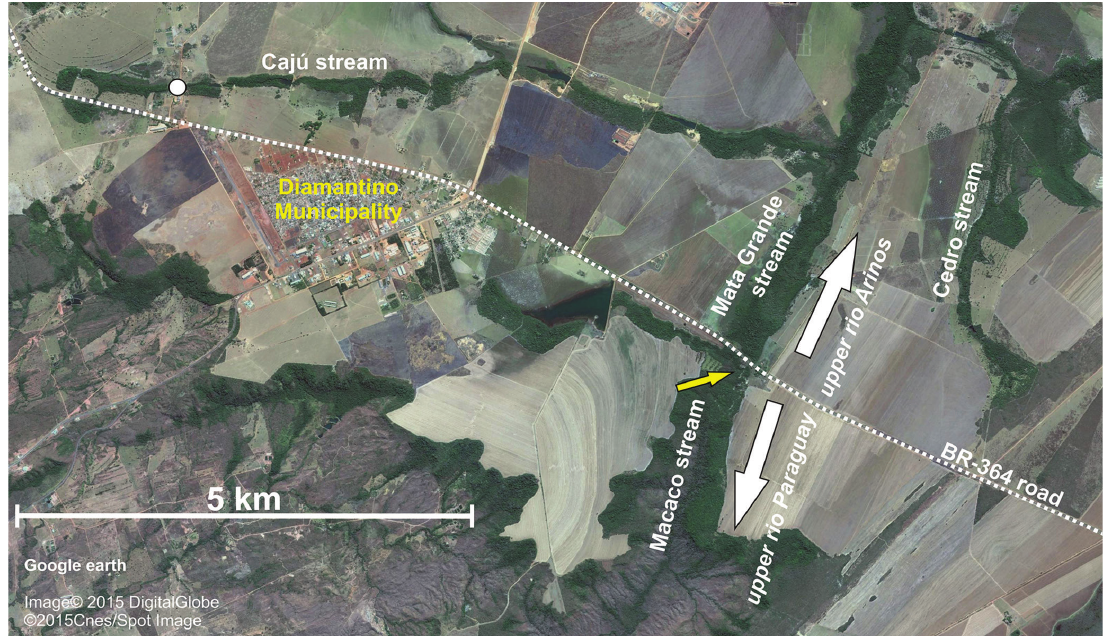
Fig. 3. Detail from the region of Diamantino Municipality, Mato Grosso State: dashed line represents BR-364, which separates the headwaters of rio Tapajós (córrego rio Preto and tributaries) and rio Paraguay basin (córrego Macaco). Yellow arrow represents the acute angle of the córrego